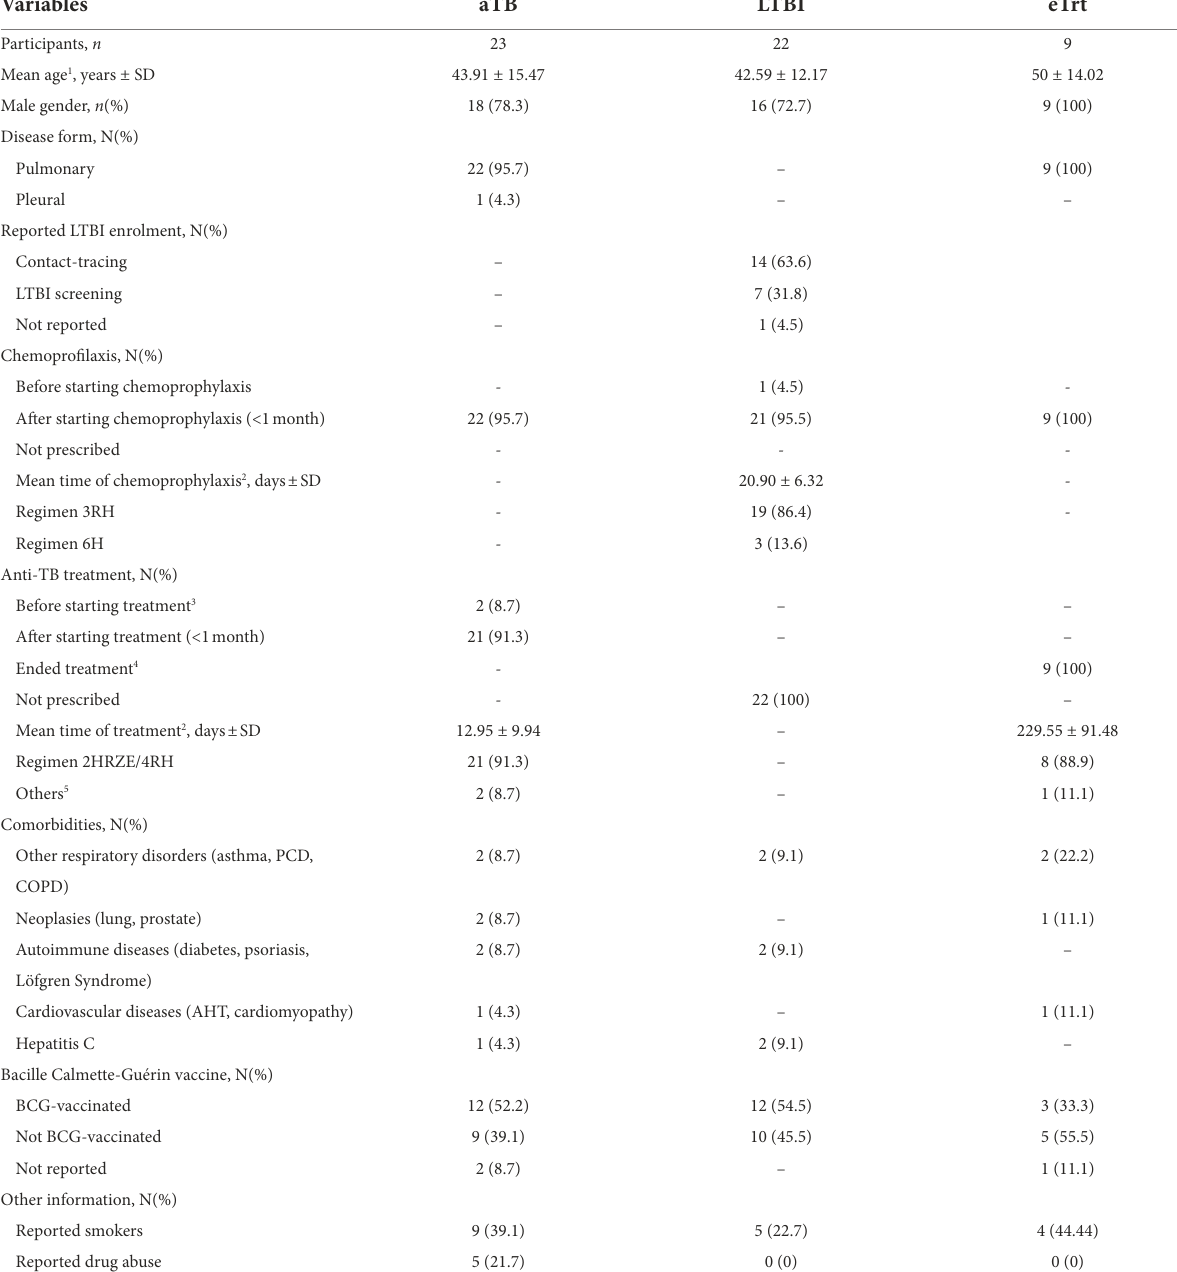
TABLE 1 Demographic and clinical characteristics of the participants in each study